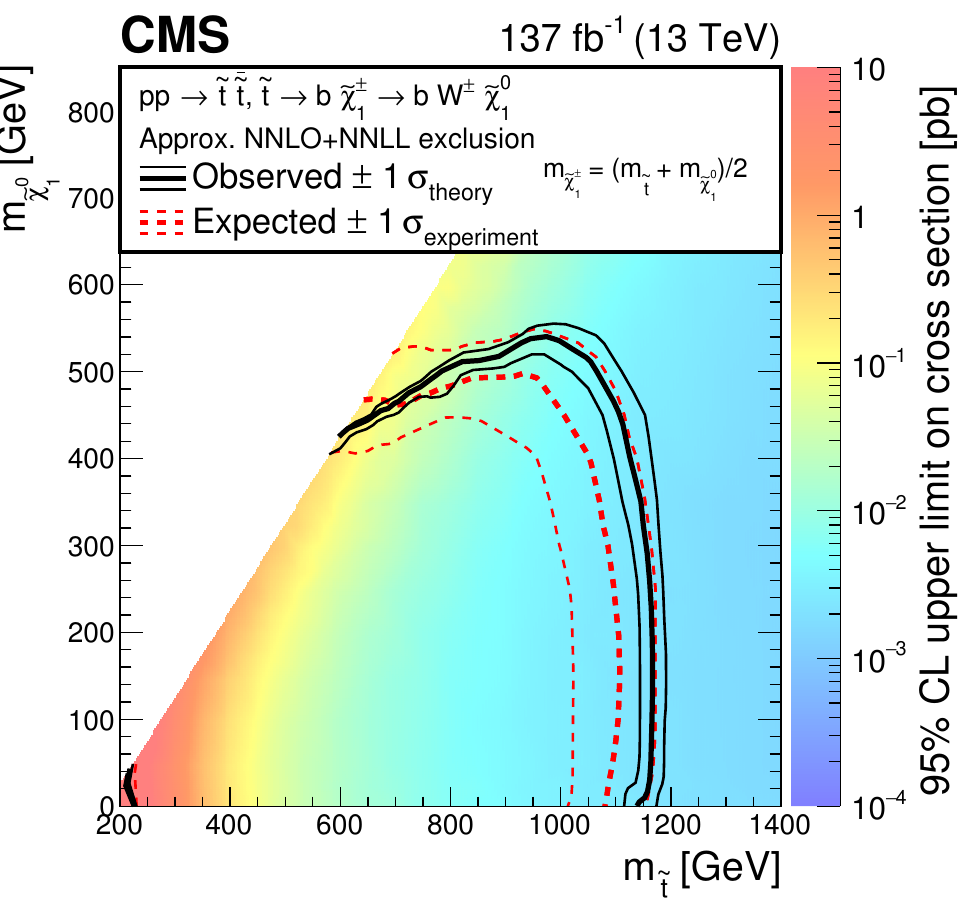
Figure 7 . Exclusion limits at 95% CL for the pp ! scenario. The (cid:31) (cid:6) mass of is chosen to be ( m + m ) = 2. The colored map illustrates the 95% CL upper limits on 0 1 e t 1 e (cid:31) e the product of the production cross section and branching fraction. The area enclosed by the thick e black curve represents the observed exclusion region, and that enclosed by the thick, dashed red curve represents the expected exclusion. The thin dotted (red) curves indicate the region containing 68% of the distribution of limits expected under the background-only hypothesis. The thin solid (black) curves show the change in the observed limit by varying the signal cross sections within their theoretical